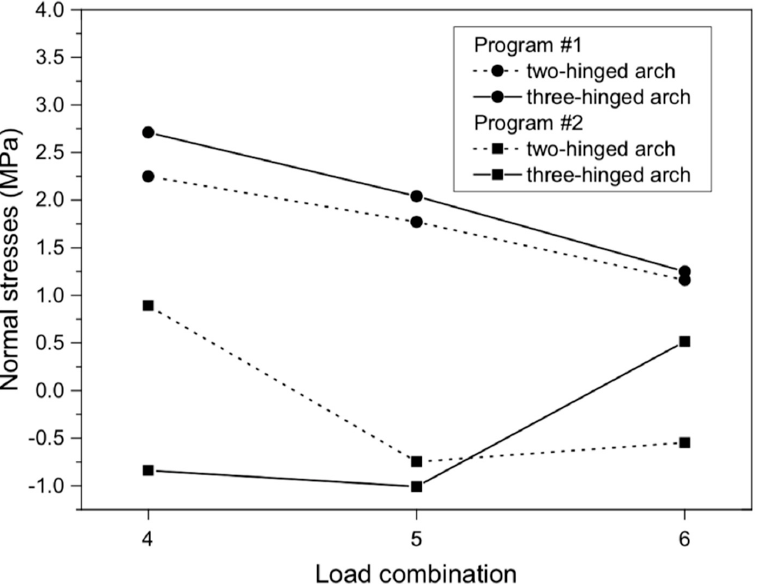
Figure 12. Maximum normal stresses of masonry arch viaduct for various load combinations.